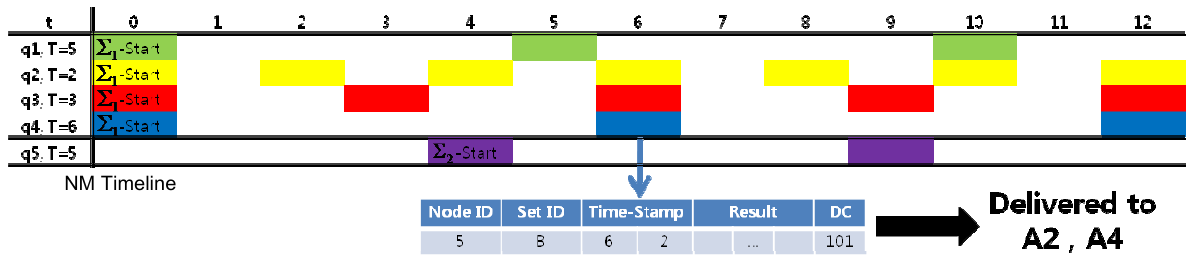
Figure 10. An example of message processing at the QRP. Analyzing the disambiguation